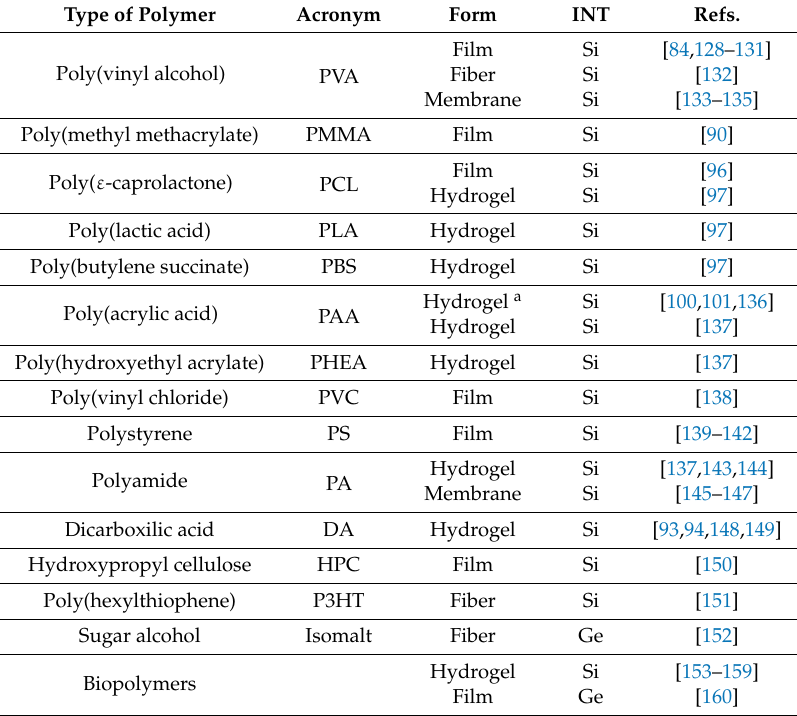
Table 3. Type of polymer used for nanocomposites preparation with INTs.